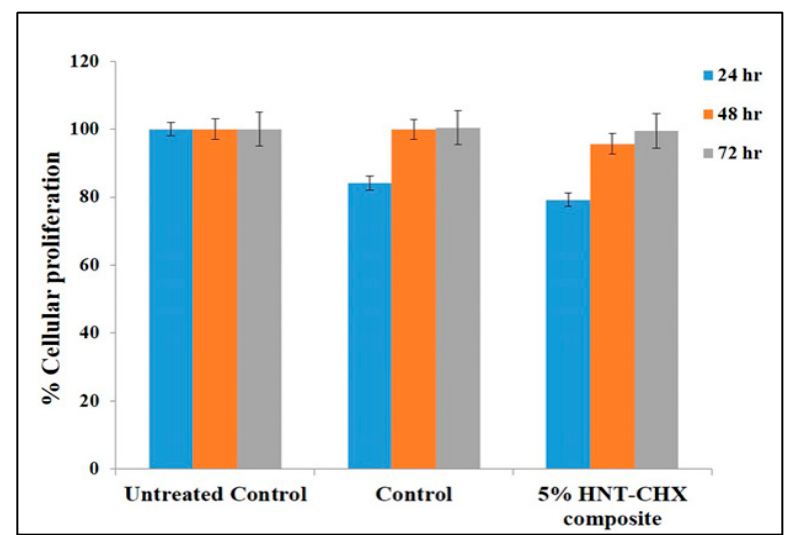
Figure 8. Cell proliferation assay. Composite samples were treated to NIH-3T3, and cytotoxicity was observed by using MTT assay. The y -axis represents percent proliferation, and the x -axis represents concentrations of compounds.